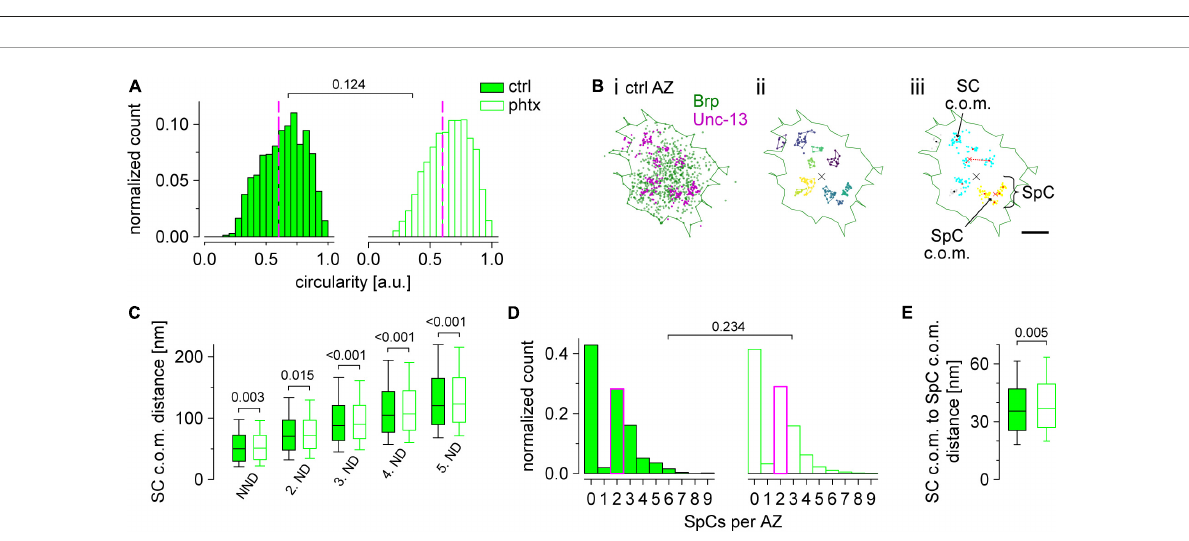
FIGURE5 Unc-13 GFSTF superclusters are enlarged in presynaptic homeostatic potentiation (PHP). (A) Active zone (AZ) circularity computed for Brp clusters in unc-13 GFSTF after dissolved in dimethyl sulfoxide (dmso) [control, ctrl; filled bars, n = 1,462 AZs from 22 neuromuscular junctions (NMJs) and nine animals] or philanthotoxin (PhTx) treatment (open bars, n = 1,521 AZs from 23 NMJs and nine animals). Dashed magenta lines indicate the cutoff circularity of ≥ 0.6 a.u. used for further analyses. (B) Scatter plots of a representative, circular AZ from a ctrl type Ib bouton. Green line indicates the alpha shape used for area determination of the AZ. (Bi) Original scatter plots of Unc-13 GFSTF and Brp Nc82 direct stochastic optical reconstruction microscopy ( d STORM) localizations. (Bii) Unc-13 GFSTF subclusters (SCs) extracted by hierarchical density-based spatial clustering of applications with noise (HDBSCAN) in different colors. Unclustered localizations are not shown. Colored lines indicate distinct alpha shapes. The center of mass (c.o.m.) of the corresponding AZ (black cross) is shown. (Biii) Two individual superclusters (SpCs), indicated by blue and yellow colors, extracted by HDBSCAN from the c.o.m.s (red dots) of Unc-13 GFSTF SCs shown in (Bii). Black dots represent SC c.o.m.s that are unclustered according to HDBSCAN analysis and gray dots show localizations of the corresponding SCs. Red crosses indicate c.o.m.s of SpCs. Dashed red line indicates the distance between a SC c.o.m. and its respective SpC c.o.m. (C) Nearest neighbor distance (NND) and 2nd to 5th neighbor distance (ND) of Unc-13 GFSTF SCs at circular AZs for ctrl ( n = 10,461, 10,425, 10,329, 10,185, and 9,945 distances from 876, 858, 826, 790, and 742 AZs for NND and 2nd to 5th ND, respectively) and phtx ( n = 10,988, 10,940, 10,856, 10,688, and 10,493 distances from 927, 903, 875, 833, and 794 AZs for NND and 2nd to 5th ND, respectively). (D) Number of SpCs per AZ. Median values, indicated in magenta, as well as statistical comparison refers to AZs with at least one SpC (ctrl: n = 501 from 22 NMJs and nine animals; phtx: n = 543 AZs from 23 NMJs and nine animals). (E) Distance between c.o.m.s of SCs and SpCs for both groups at AZs with at least one SpC ( n = 1,417 and 1,497 SpCs for ctrl and phtx,